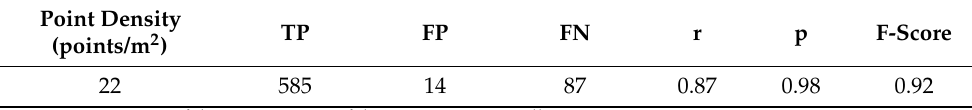
Table 5. The results of automatic tree